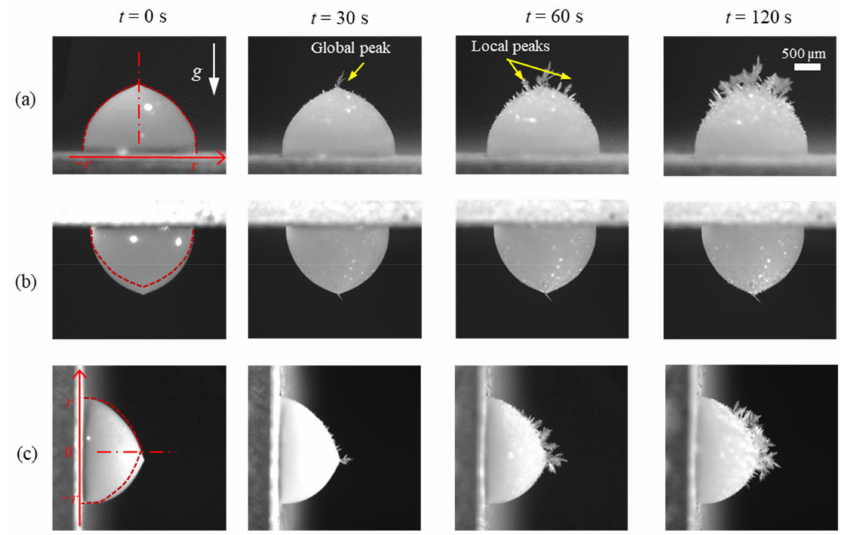
Figure 3. Growth dynamics of ice dendrites atop a frozen water drop placed on a ( a ) horizontally, ( b ) inverted, and ( c ) vertically orientated supercooled